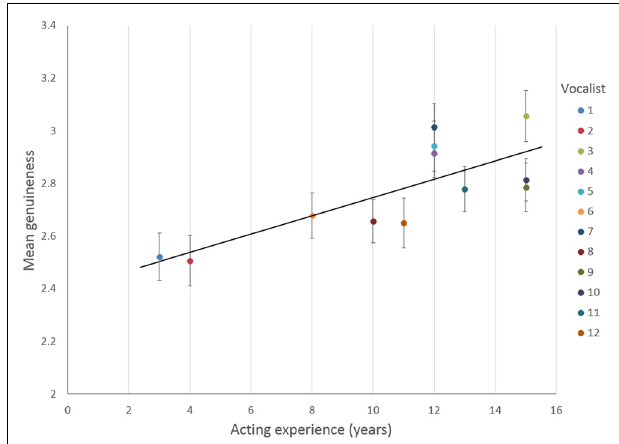
FIGURE 3 | Listeners’ mean genuineness ratings for each vocalist, and vocalists’ years of acting experience in Experiment 2. Solid black line indicates a line of best fit, with a linear regression solution: Genuineness = 2.4 + 0.035 × Acting experience. Error bars denote the standard error of the